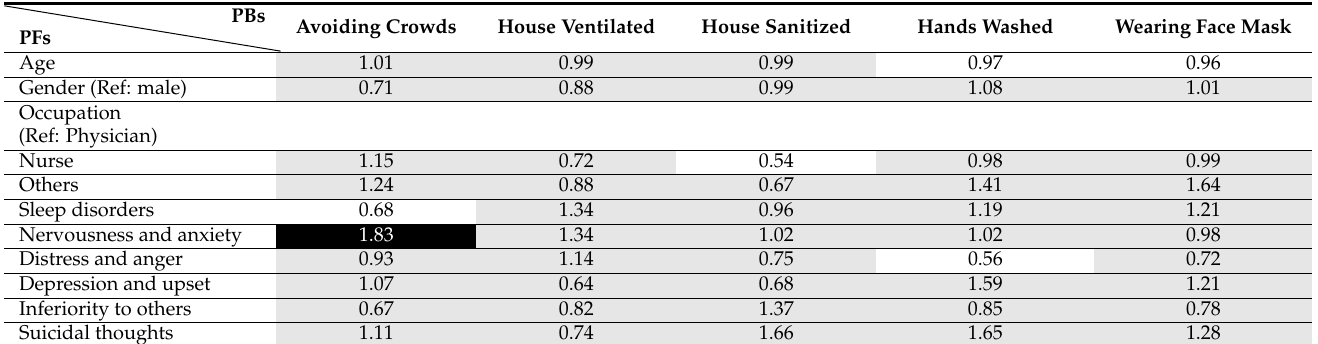
Table 3. Multiple logistic regression of predicting factors (PFs) to preventive behaviors